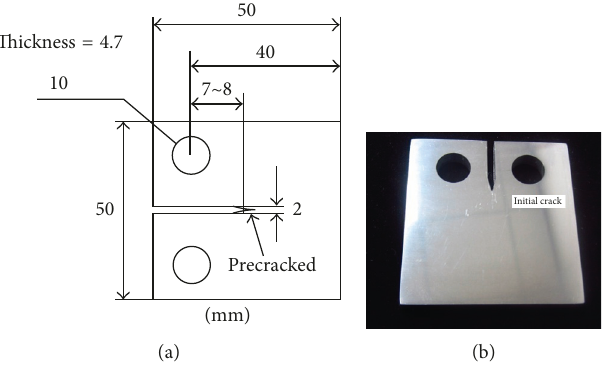
Figure 5: Geometry of CT specimen and precracked